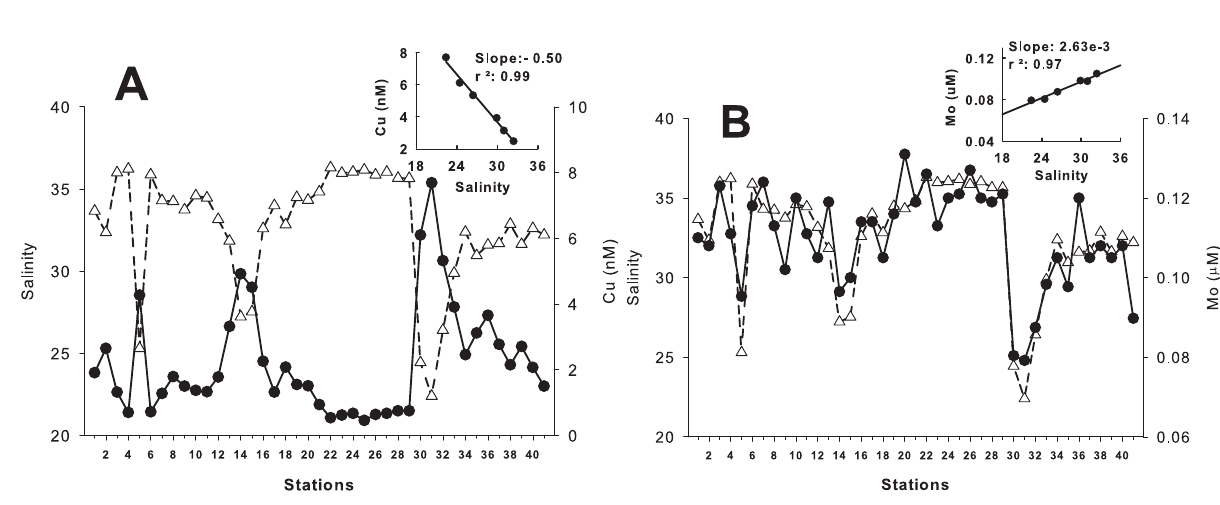
Fig. 2. Geographical distribution of surface salinity (triangles), dissolved Cu (panel (a) – filled circles) and Mo (panel (b) – filled circles) measured in the western boundary of the subtropical North Atlantic Ocean. The insets represent linear regressions of the dissolved elements plotted against salinity for six different sampling times over a 24-h